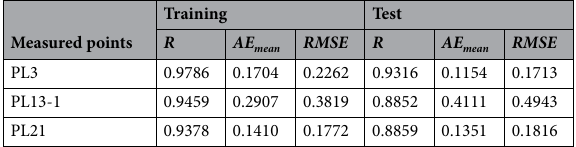
Table 2. Performance parameters of MLSR model.